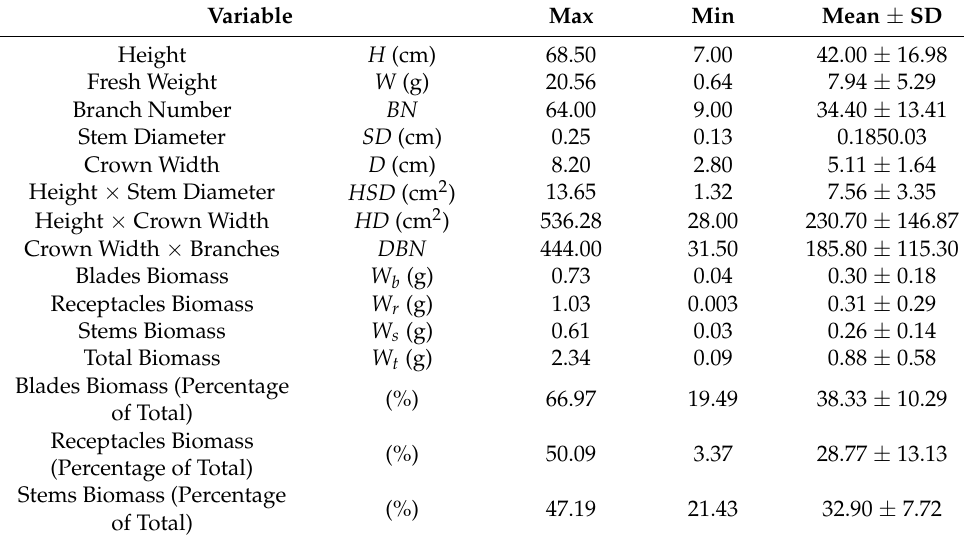
Table 1. Biological parameters of Sargassum fusiforme